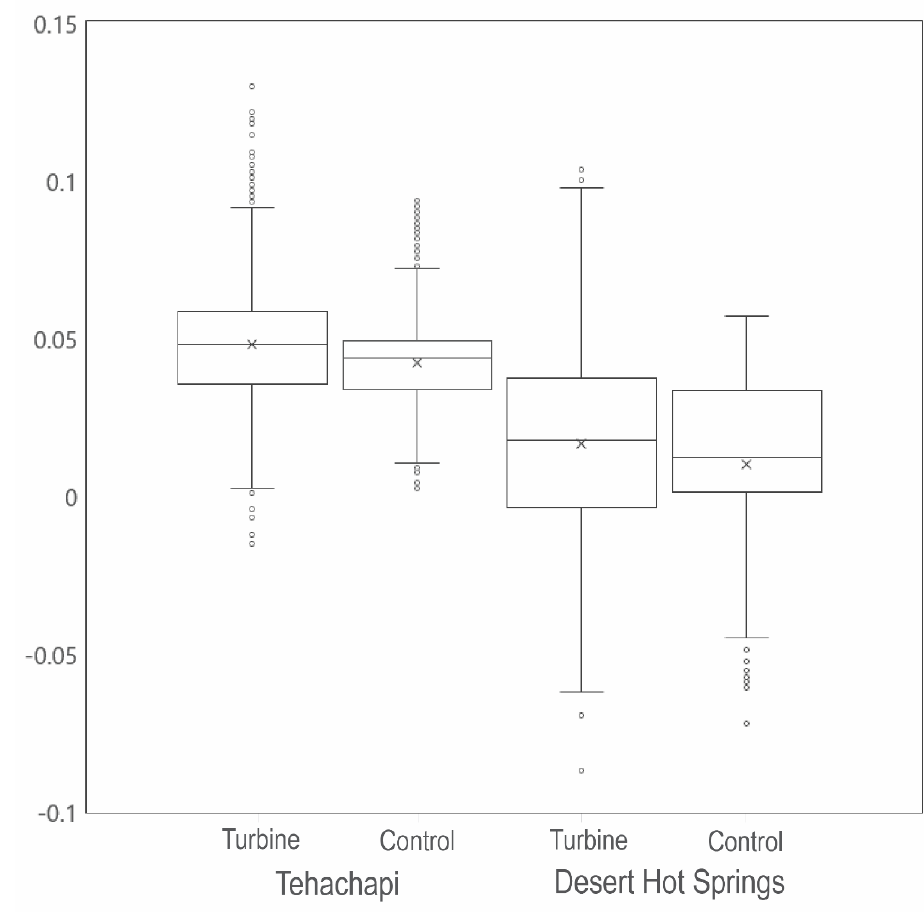
Figure 5. Boxplots of the di ff erence (post-installation minus pre-installation) in Early Season Invasives (ESI) index values for turbines and control sites at the Tehachapi and Desert Hot Springs wind energy sites. p -values from ANOVA test between turbine and control were < 0.001 for both Tehachapi and Desert Hot Springs.